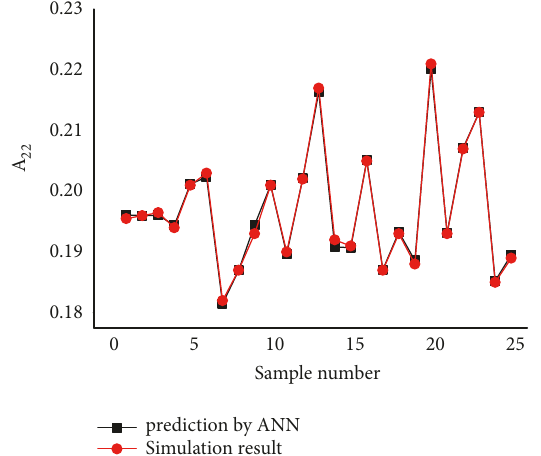
Figure12:InteractioneffectofdelaytimeandwaterpressureonA 22 .